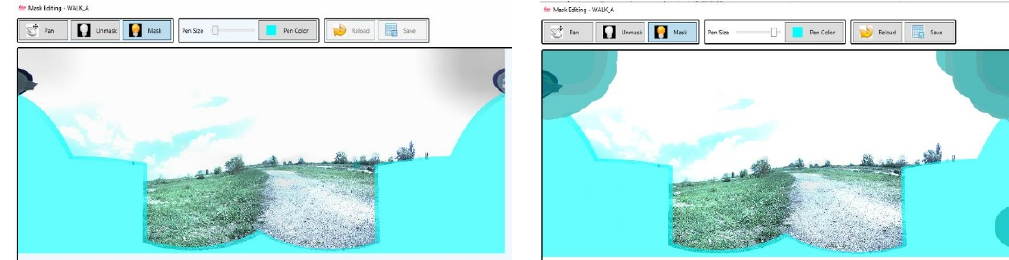
Figure 13. Before and after masking the global navigation satellite systems (GNSS) antenna.